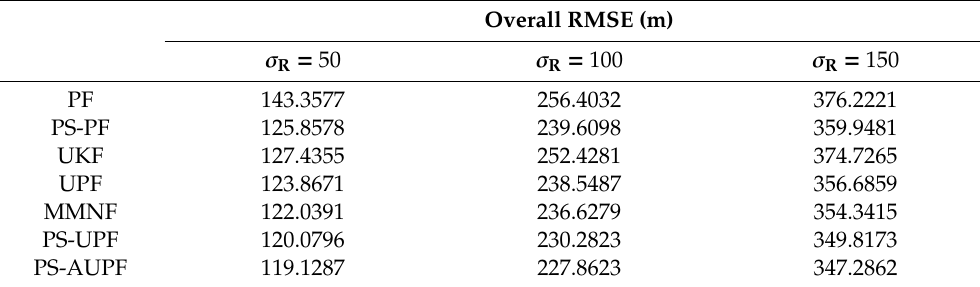
Table 4. Tracking RMSE of each algorithm with Rayleigh